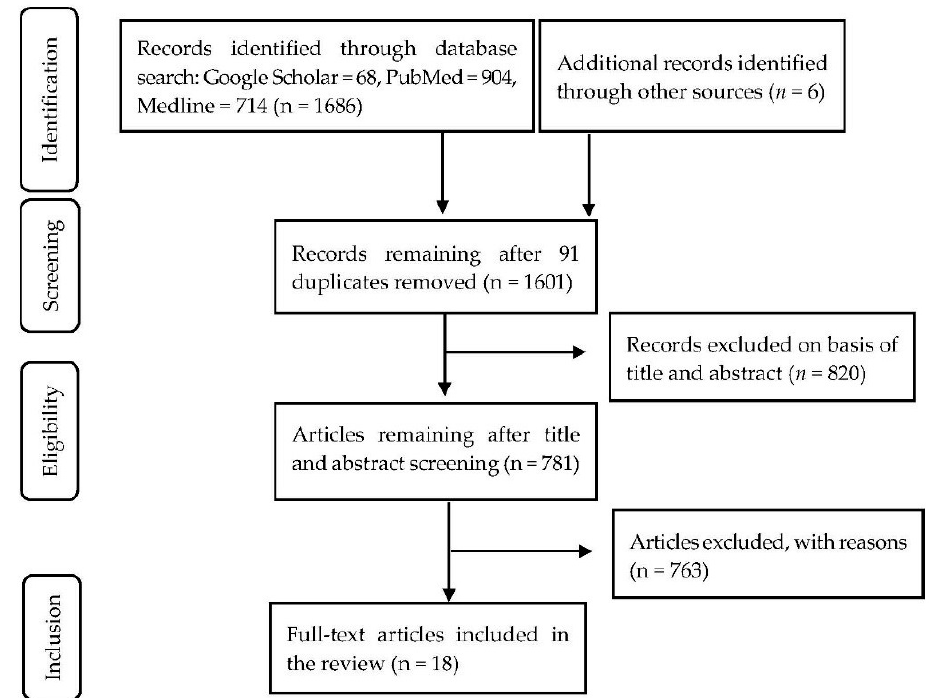
Figure 1. Study selection Preferred Reporting Items for Systematic Reviews and Meta-Analyses (PRISMA) flow diagram.2.2. Data Extraction and Synthesis.